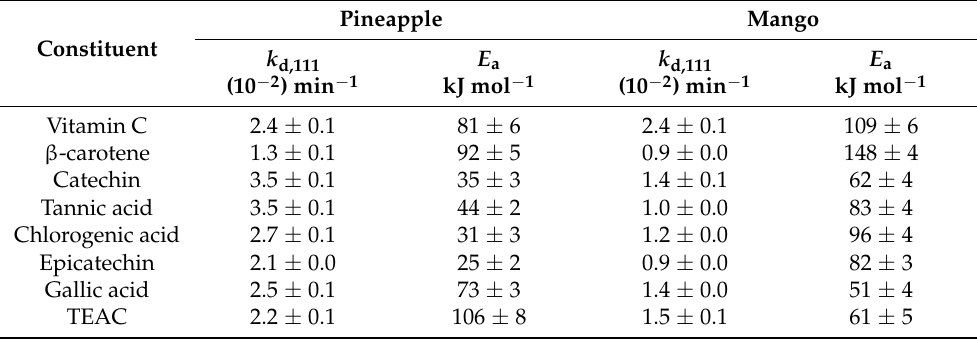
Table 2. Kinetic parameters for the degradation of compounds in pineapple and mango during canning (first-order model). Values are given with their 95% confidence